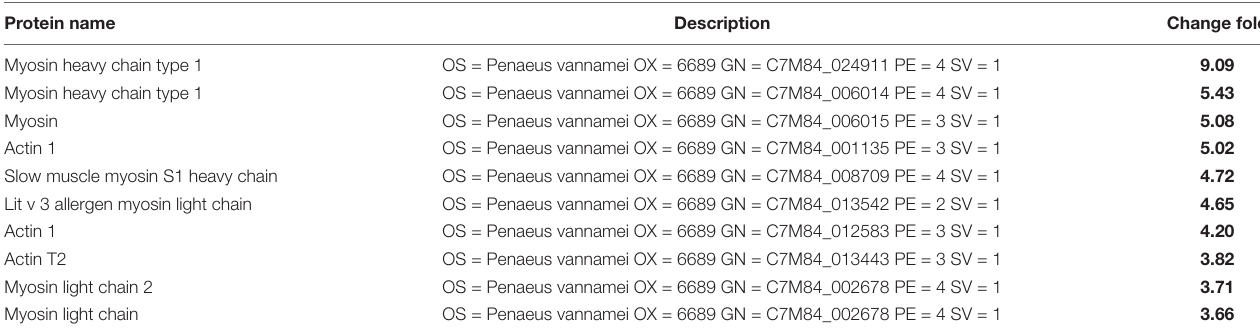
TABLE 1A | Top 10 texture-related differential proteins in Litopenaeus vannmei of SS-128 vs. CG.